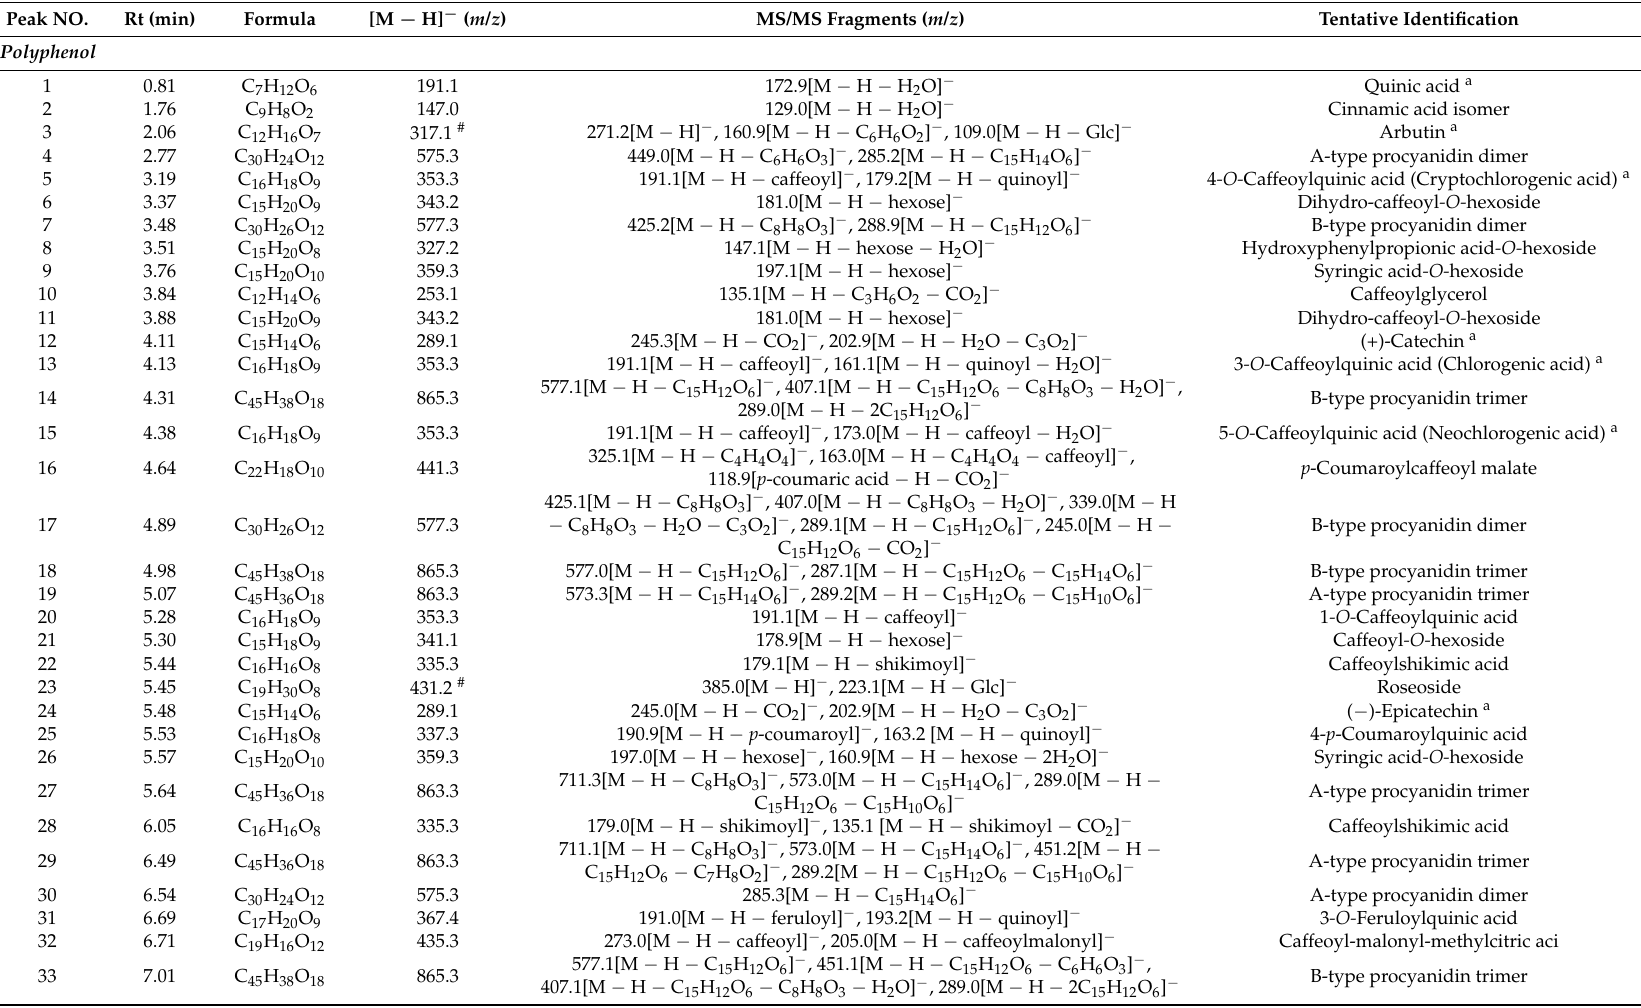
Table 1. Characterization of chemical compounds in young pear fruits by ultra-performance liquid chromatography coupled with electrospray ionization triple quadrupole mass spectrometry (UPLC-Q TRAP-MS/MS). Peak